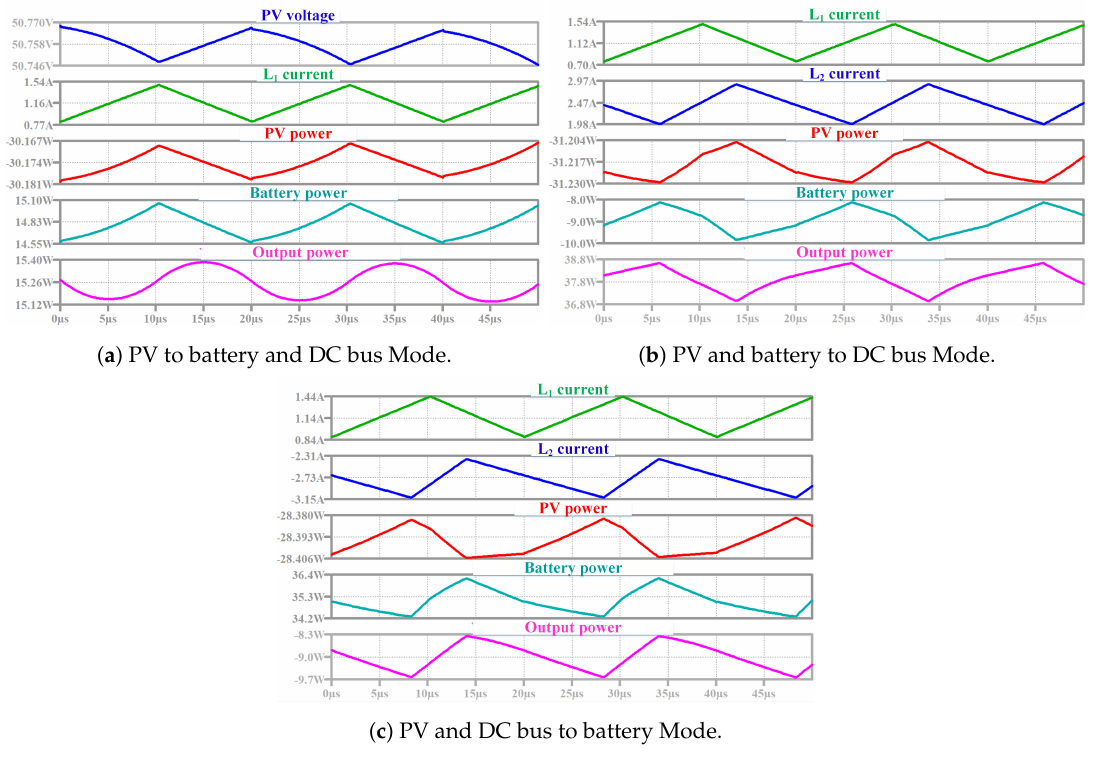
Figure 16. Simulation results of Type